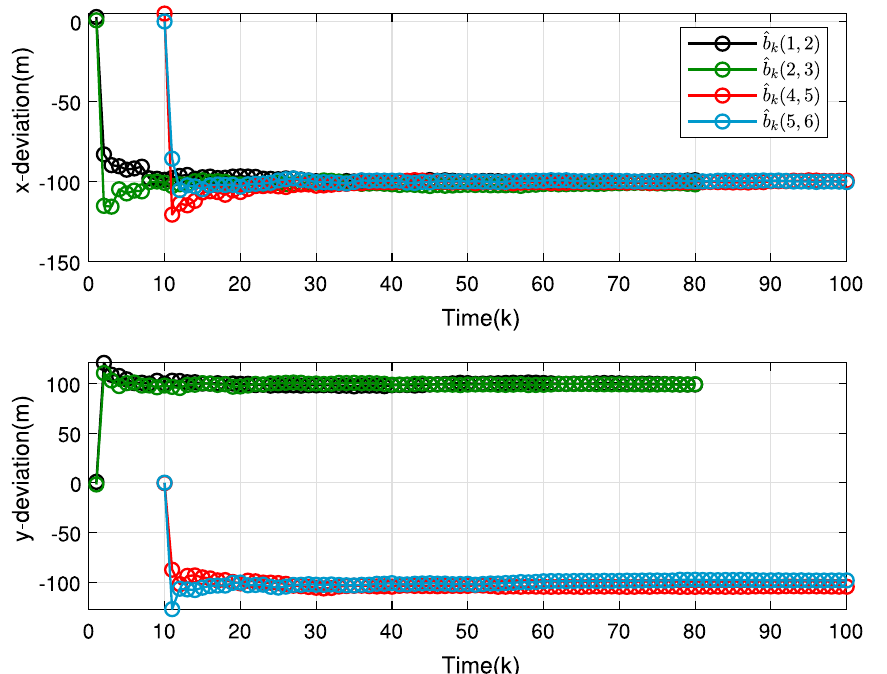
Fig. 13 Estimation of the